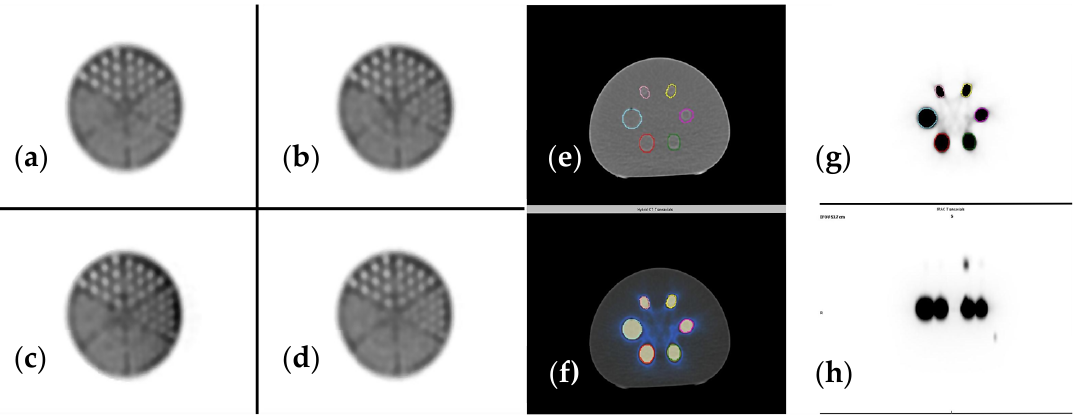
Figure 4. ( a – d ) Jaszczak phantom reconstructed using different iterations and subsets, ( e ) CT image ( f ) SPECT-CT image, ( g ) SPECT axial view, ( h ) SPECT sagittal view of NEMA phantom used for accurate scanner calibration.